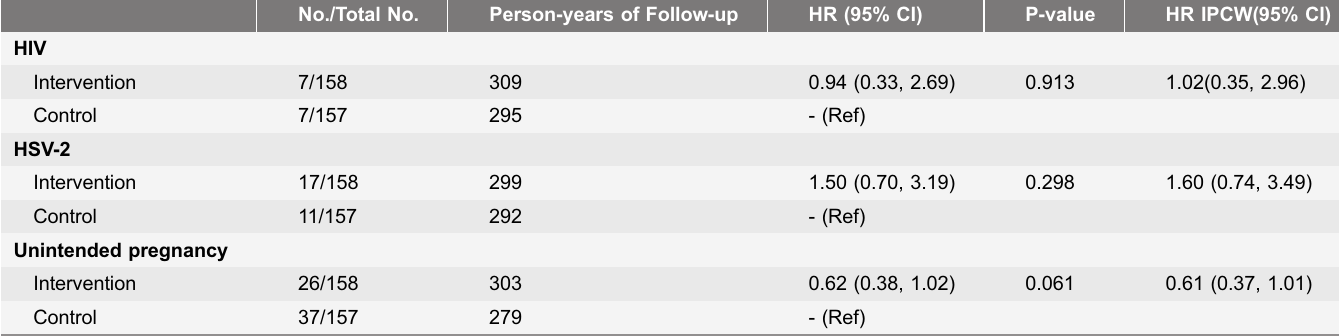
Table 3. Effect of participation in the intervention arm (vs. control) on biological outcomes. No./Total